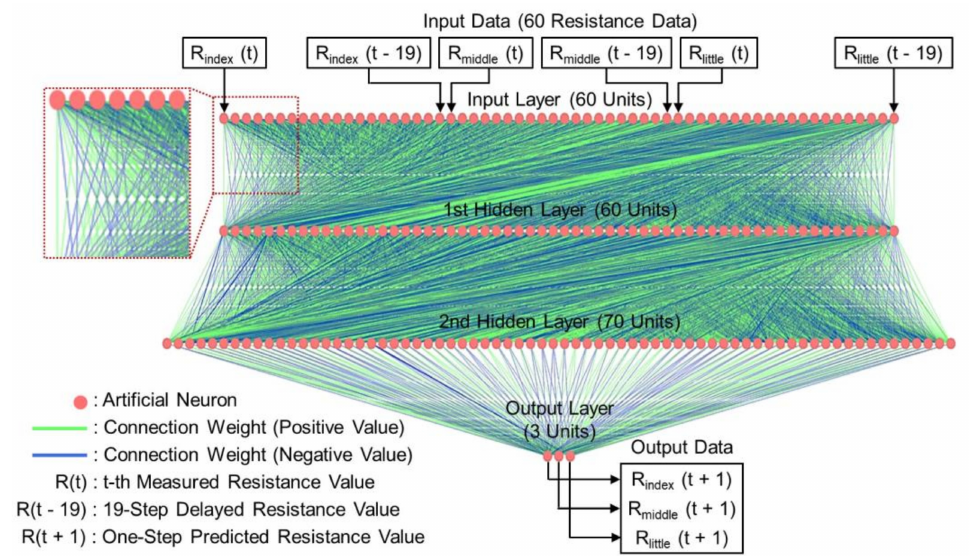
Figure 3. Architecture of the TDNN model with two hidden layers. Green and blue connection lines represent positive and negative relationships,